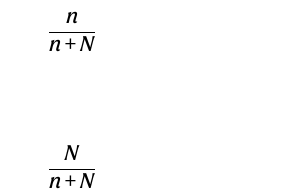
Supplementary Fig. 21, and Supplementary Fig. 22, coordinates of ESs and rRNA:ribosomal protein interactions were retrieved from ref.